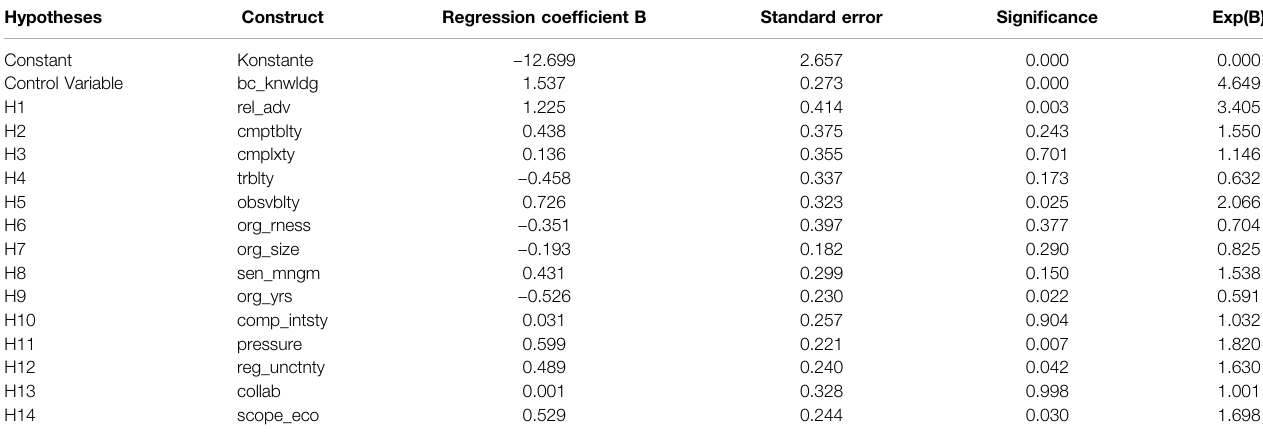
TABLE 6 | Results of